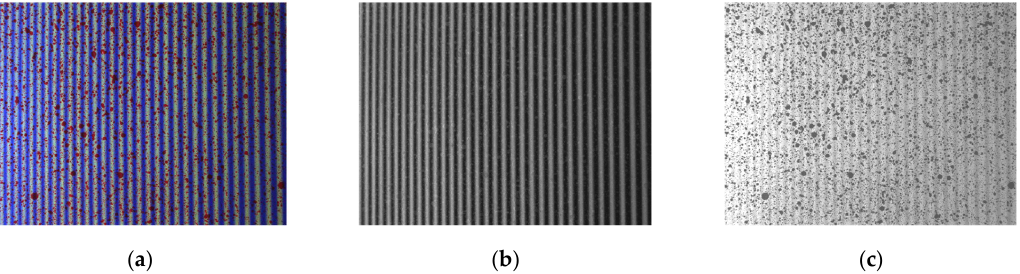
Figure 5. Original image RGB decomposing process. ( a ) Original RGB image; ( b ) fringe image; ( c ) speckle image.